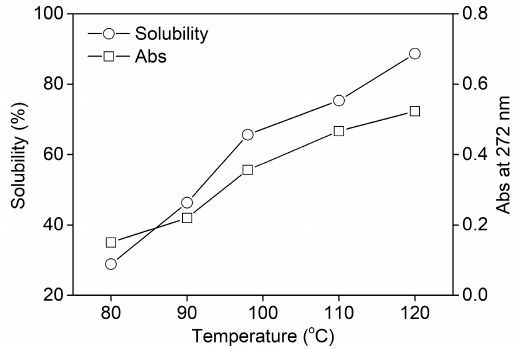
Figure 2. Solubility of rabbit hair in DES at various temperatures.